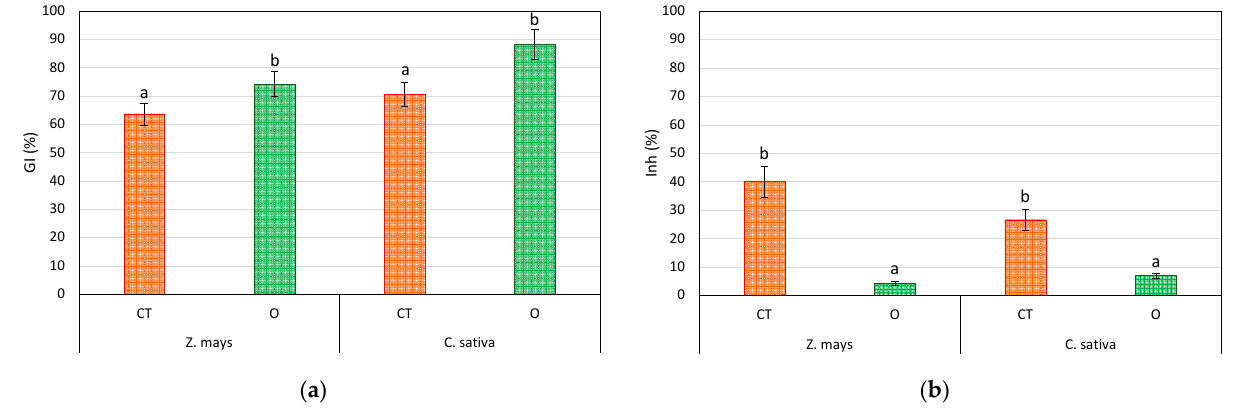
Figure 2. ( a ) Germination index ( GI %) and ( b ) root elongation inhibition ( Inh %) for Z. mays and C. sativa grown on soil control (CT), As-contaminated soil and As-contaminated soil treated with a 0.2 M KHC 2 O 4 + 0.01 M C 6 H 8 O 6 solution (O). Values are the means of three replicates and the error bars show the standard deviations. Values with different letters are significantly different at the 5% probability level (Tukey’s test).